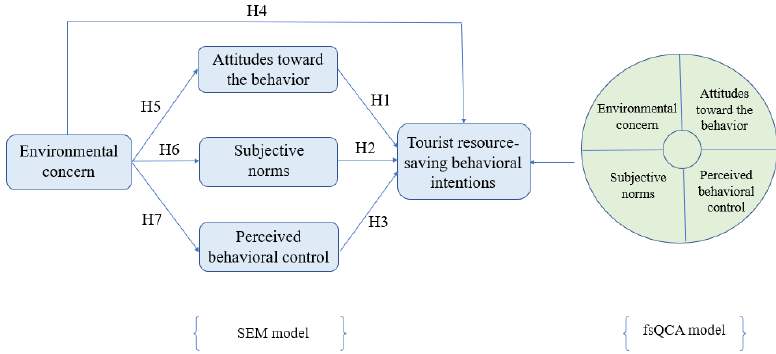
Figure 1. Conceptual model.